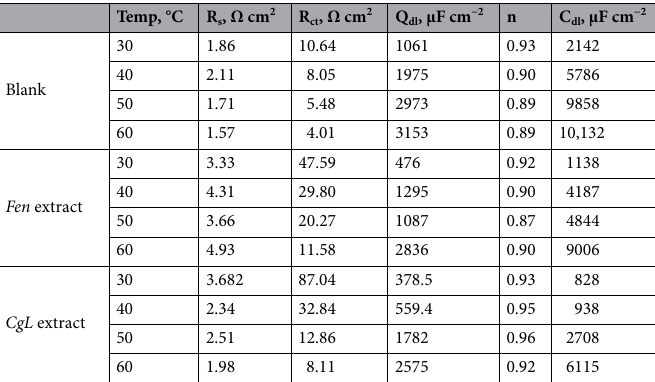
Figure 9. Nyquist impedance plot of steel in 20% phosphoric acid in ( a ) the absence and presence of ( b ) 0.8 g/L Fen and ( c ) 0.4 g/L CgL extract at different temperatures.